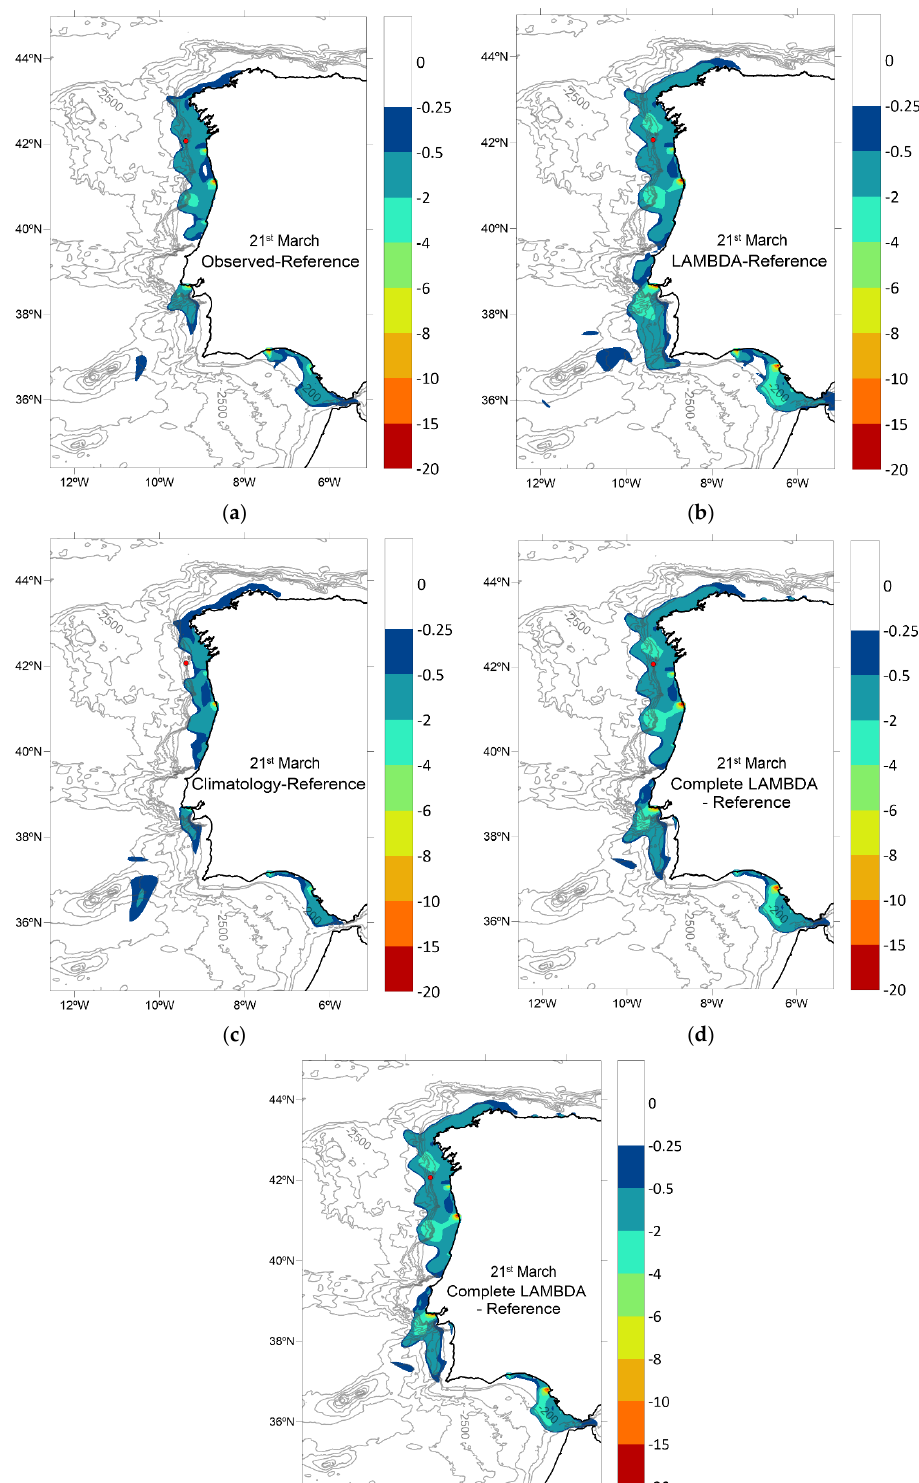
Figure 13. Surface salinity difference during the 21 March 2018 between the reference scenario with each LAMBDA land boundary scenarios ( a ) Observed; ( b ) LAMBDA; ( c ) Climatology; ( d ) Complete Observations; ( e ) Complete LAMBDA. Salinity difference between 0 and − 0.5 is not represented.